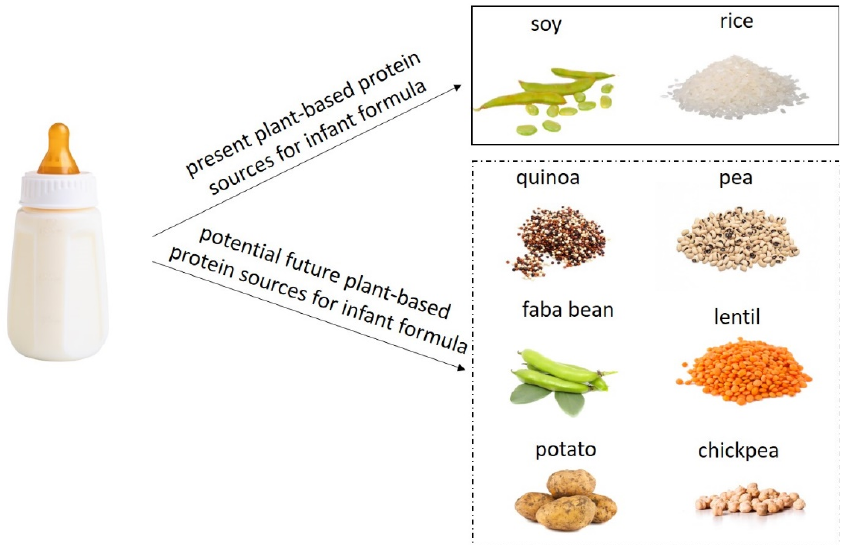
Figure 5. Present and potential future plant ‐ based protein sources for infant formula manufacture.